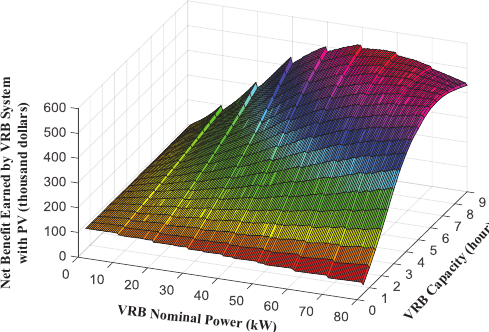
Figure 9. Net economic benefit earned by the VRB system with PV (in thousand dollars).